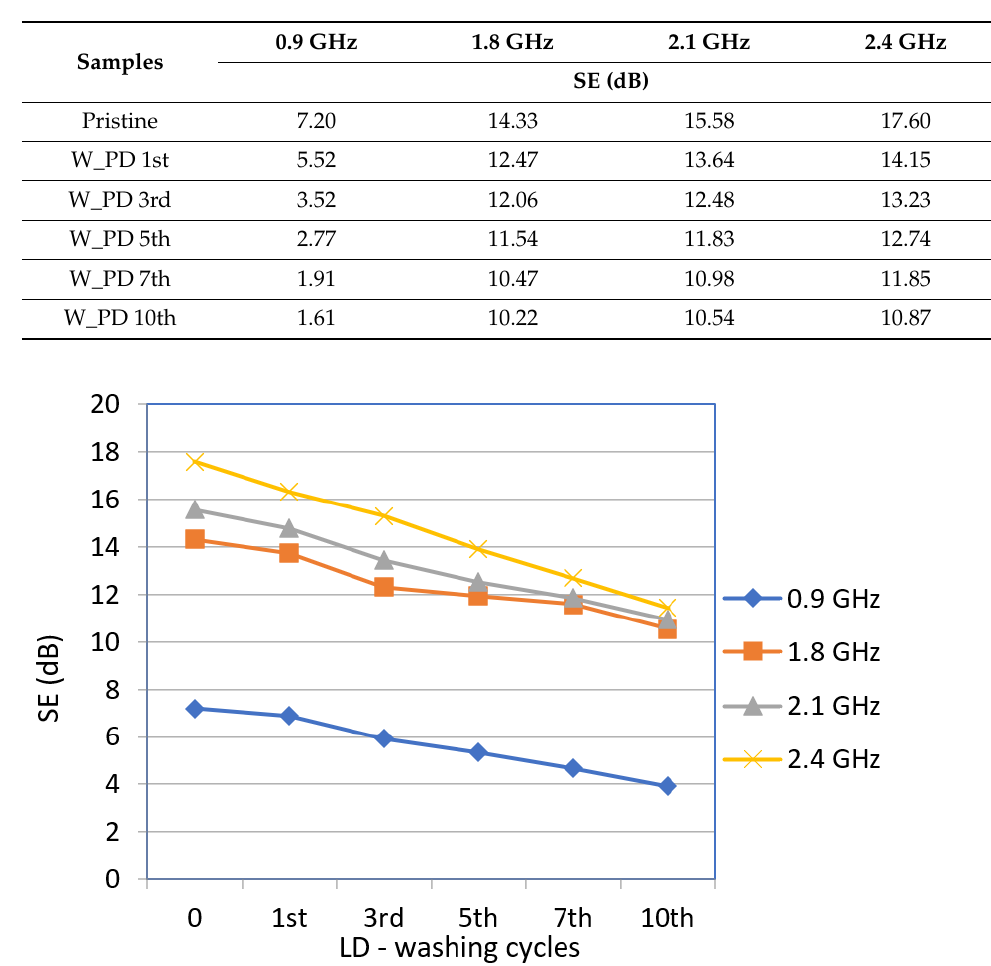
Figure 4. Shielding effectiveness (SE) of the fabric sample with stainless steel (face) before and after the 1st, 3rd, 5th, 7th, and 10th washing cycles with liquid detergent at frequencies 0.9 GHz, 1.8 GHz, 2.1 GHz, and 2.4